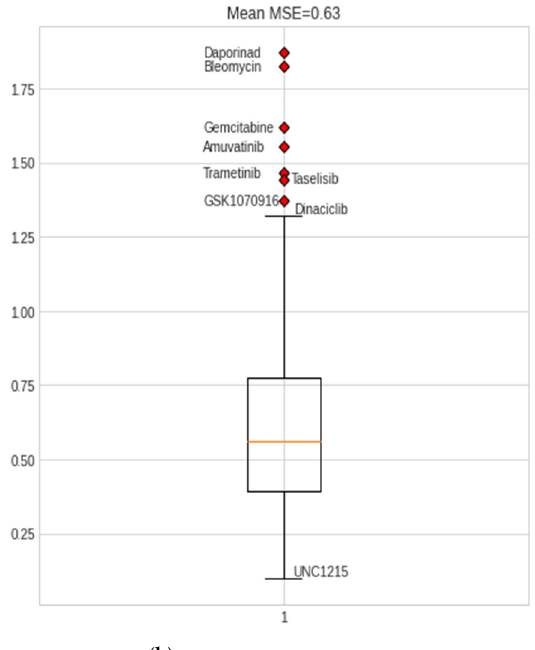
Figure 3. Analysis of genes from mutation omics data using Metascape. ( a ) GO Analysis. ( b ) Pro- tein–protein interactions of the shortlisted genes. ( c ) DisGeNET analysis reflecting the top ranked gene contributions to BC. ( d ) Wiki and Go pathway results .